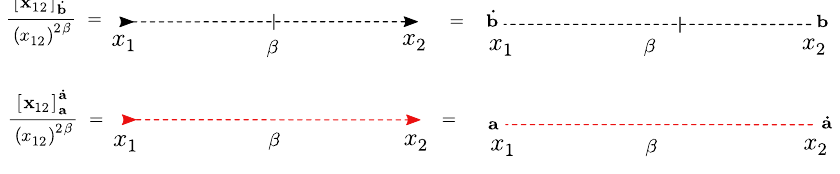
( u, x ) of (2.16) with conformal 1 − x 2 ‘ ˙ ‘